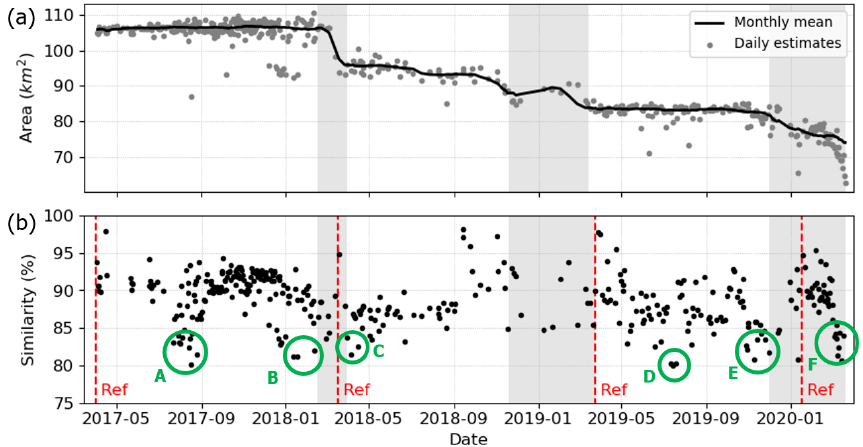
Figure A1. (a) Area changes of the tracked iceberg B43 (same to Fig. 8a). Gray shaded areas indicate the split-off events of the iceberg. (b) Variations of similarity values by time. Red vertical dashed lines indicate the timing of manual digitization to define the reference iceberg. Green circles A–F indicate six distinctive low-similarity dates ( < 85% similarity).